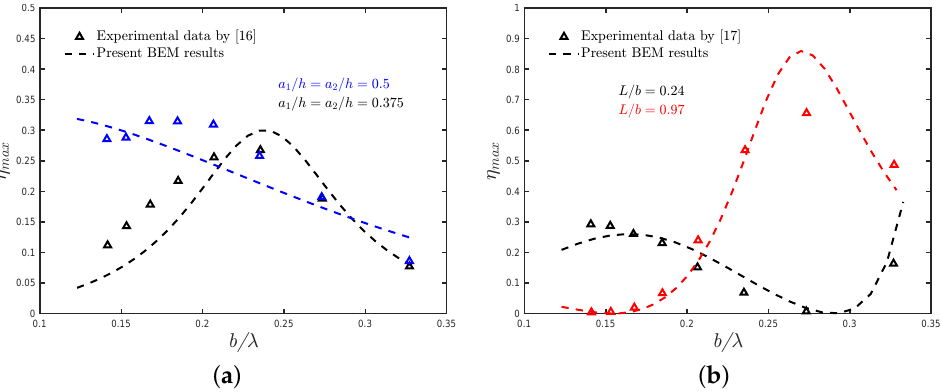
Figure 4. Comparison of the present results for the hydrodynamic efficiency η max with the experi- mental results obtained by ( a ) [16] for a pile-supported OWC device and ( b ) [17] for an OWC device near a reflecting vertical